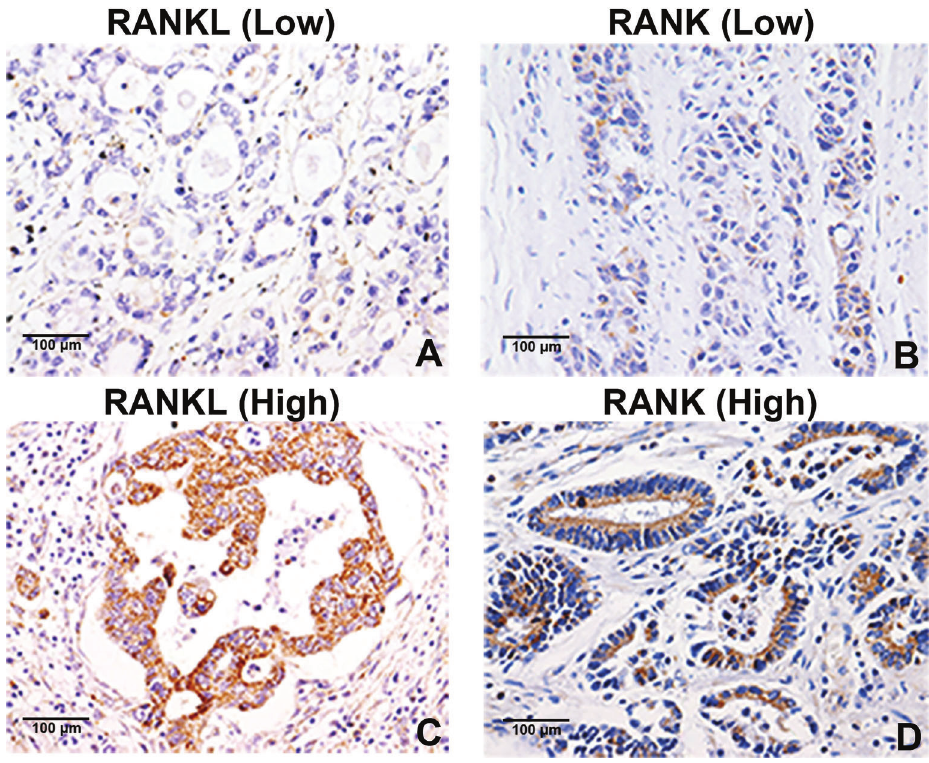
Figure 1. Expression of RANKL and RANK in gastric cancer tissues. RANKL ( A ) and RANK ( B ) low staining levels; RANKL ( C ) and RANK ( D ) high staining levels (in brown). Magni fi cation (cid:1)